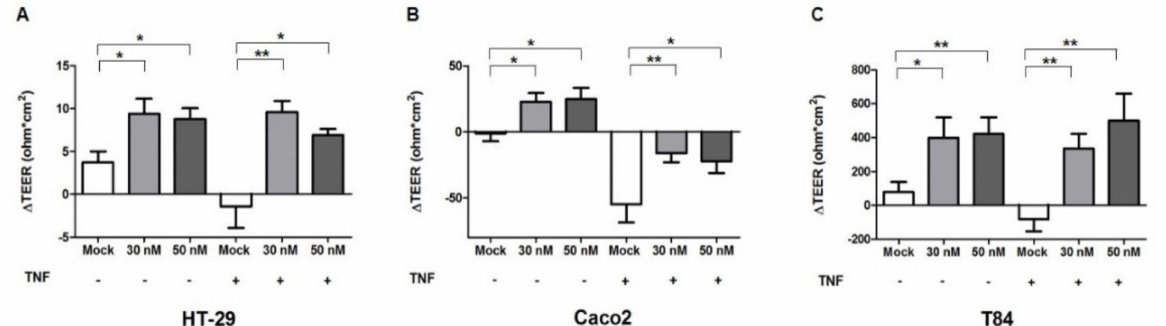
Figure 4. Effect of miR-195-5p in the regulation of intestinal barrier function. Ectopic expression of miR-195-5p in HT-29 ( A ), Caco2 ( B ) and T84 ( C ) cell lines increased the TEER even after stimulation with TNF- α . The value of ∆ TEER (ohms*cm 2 ) was obtained by subtracting the measured value at 48 h after TNF- α stimulation from the TEER value measured just before the transfection. Data are representative of four independent experiments. The histograms correspond to mean ± SEM. * p < 0.05; ** p <